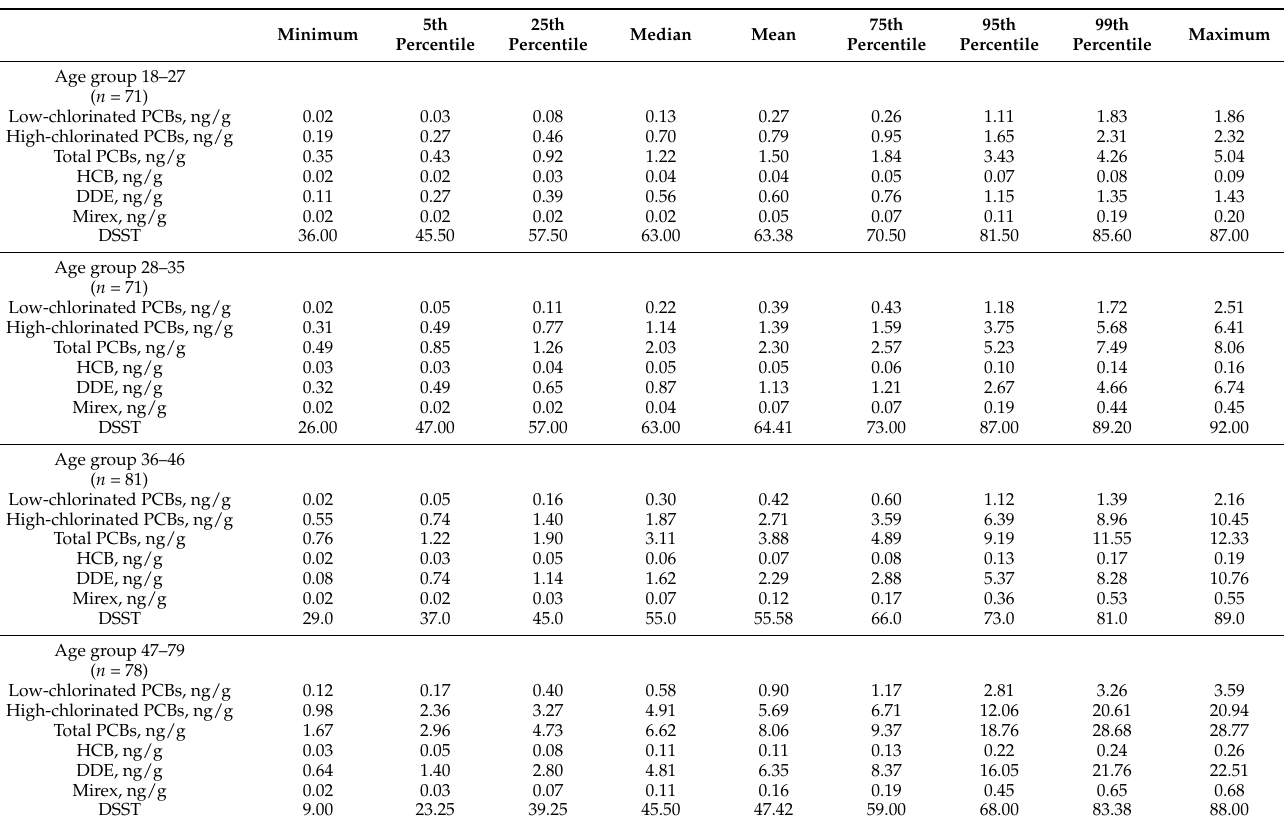
Table 2. Distribution of low-chlorinated PCBs, high-chlorinated PCBs, total PCBs, HCB, DDE, and mirex in Mohawk nation participants ( n = 301) by age